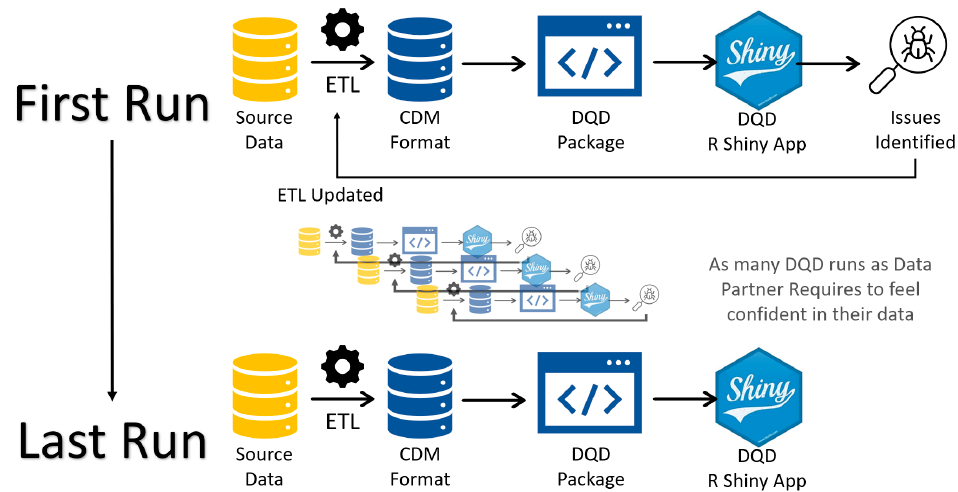
Figure 2. The Extract, Transform, & Load (ETL) to Common Data Model (CDM) to Data Quality Dashboard (DQD) Feedback Loop used in the European Health Data & Evidence Network (EHDEN) COVID-19 Rapid Collaboration Call.